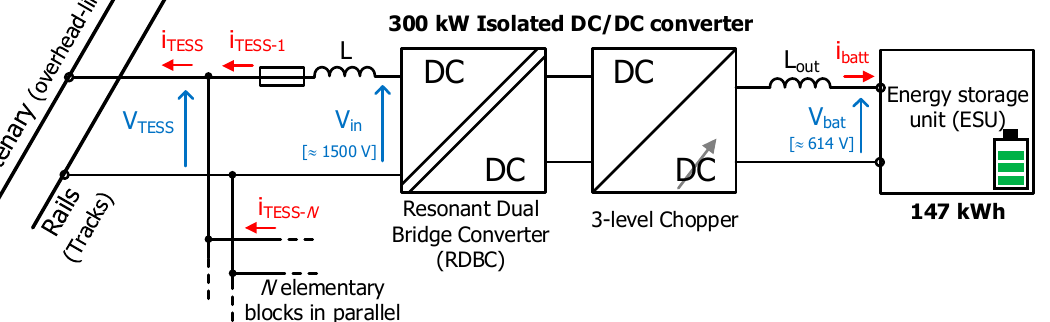
Figure 3. Paralleling principle for reinforcing a DC railway line sector with N elementary isolated trackside energy storage systems.